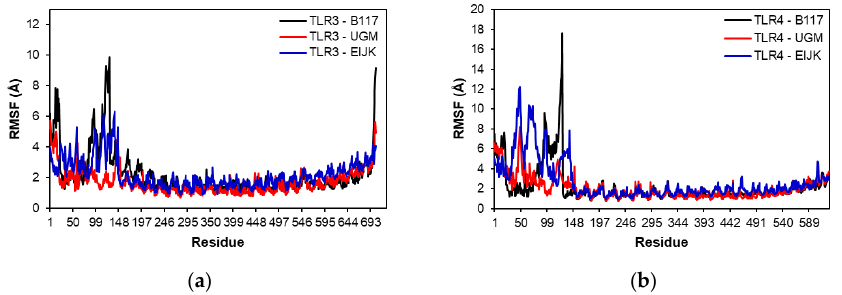
Figure 7. RMSF of TLR-3 ( a ) and TLR-4 ( b ) complexes.